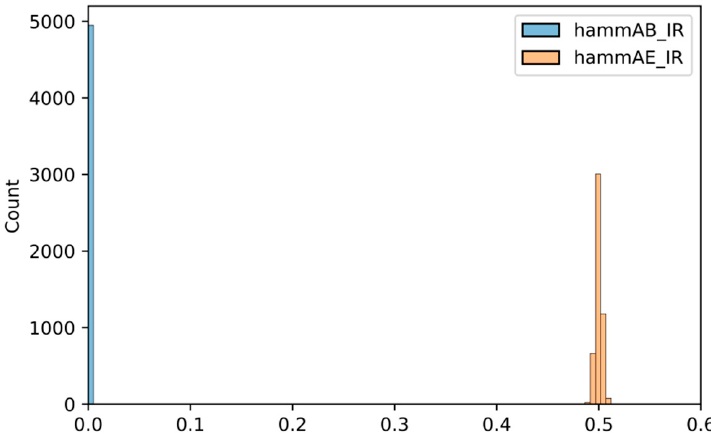
Figure 11. Histogram of normalized Hamming distances between Alice and Bob (0.0 ± 0.0), and Alice